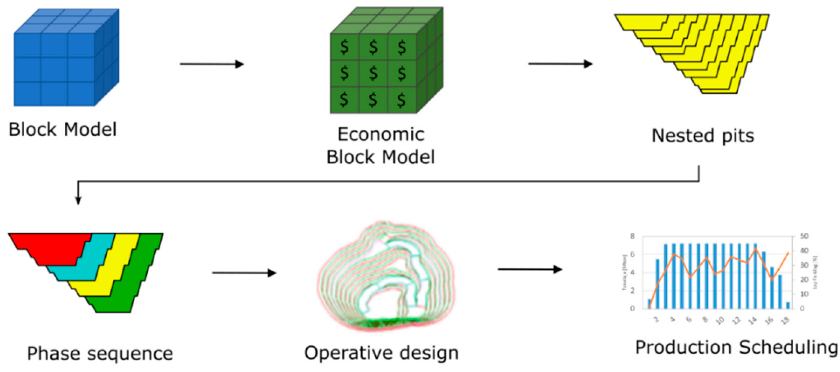
Figure 1. Traditional methodology for long-term open-pit mine planning (adapted from [5]).